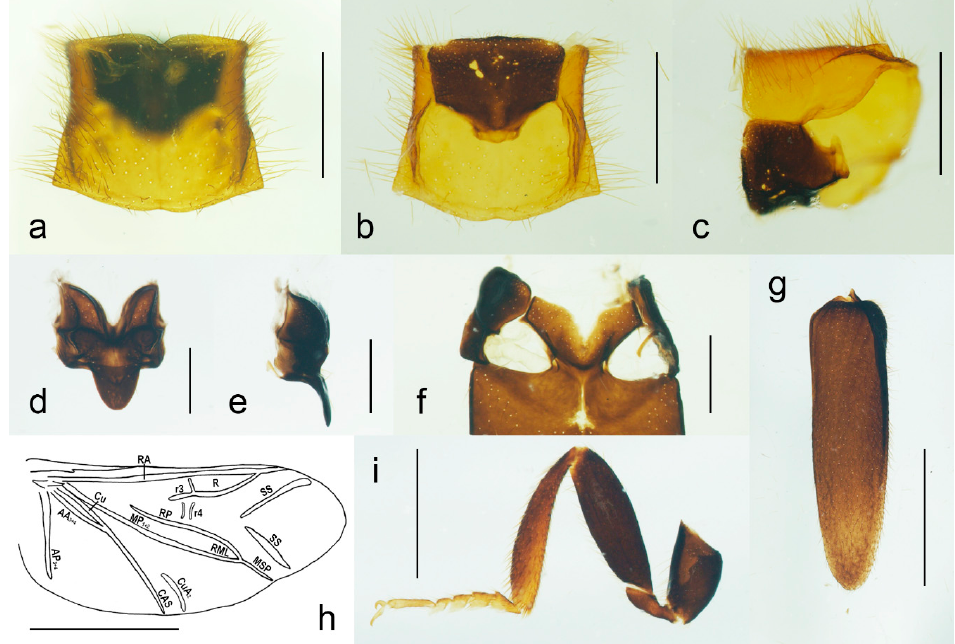
Figure 4. Malacogaster passerinii Bassi, 1834 from Sardinia, Italy (PCRK), male, details of morphology. ( a ) Prothorax dorsal view; ( b ) prothorax, ventral view; ( c ) prothorax, lateral view; ( d ) scutellum, dorsal view; ( e ) scutellum, lateral view; ( f ) mesoventrite, ventral view; ( g ) right elytron, dorsal view; ( h ) hind wing; ( i ) hind leg. Scale bars = ( a – c , i ) 1.0 mm; ( d – f ) 0.5 mm; ( g ) 2.0 mm; ( h ) 2.5 mm. AA3 + 4 = Anal Anterior (branches 3 + 4); AP3 + 4 = Anal Posterior (branches 3 + 4); Cu = Cubitus; CuA2 = Cubitus Anterior, branch 2; CAS = Cubitoanal Strut; MP1 + 2 = Media Posterior (branches 1 + 2); MSP = Medial Spur; R = Radial Cell; r3 = radial cross-vein 3; r4 = radial cross-vein 4; RA = Radius Anterior; RML = Radiomedial Loop; RP = Radius Posterior; SS = Support Sclerites.